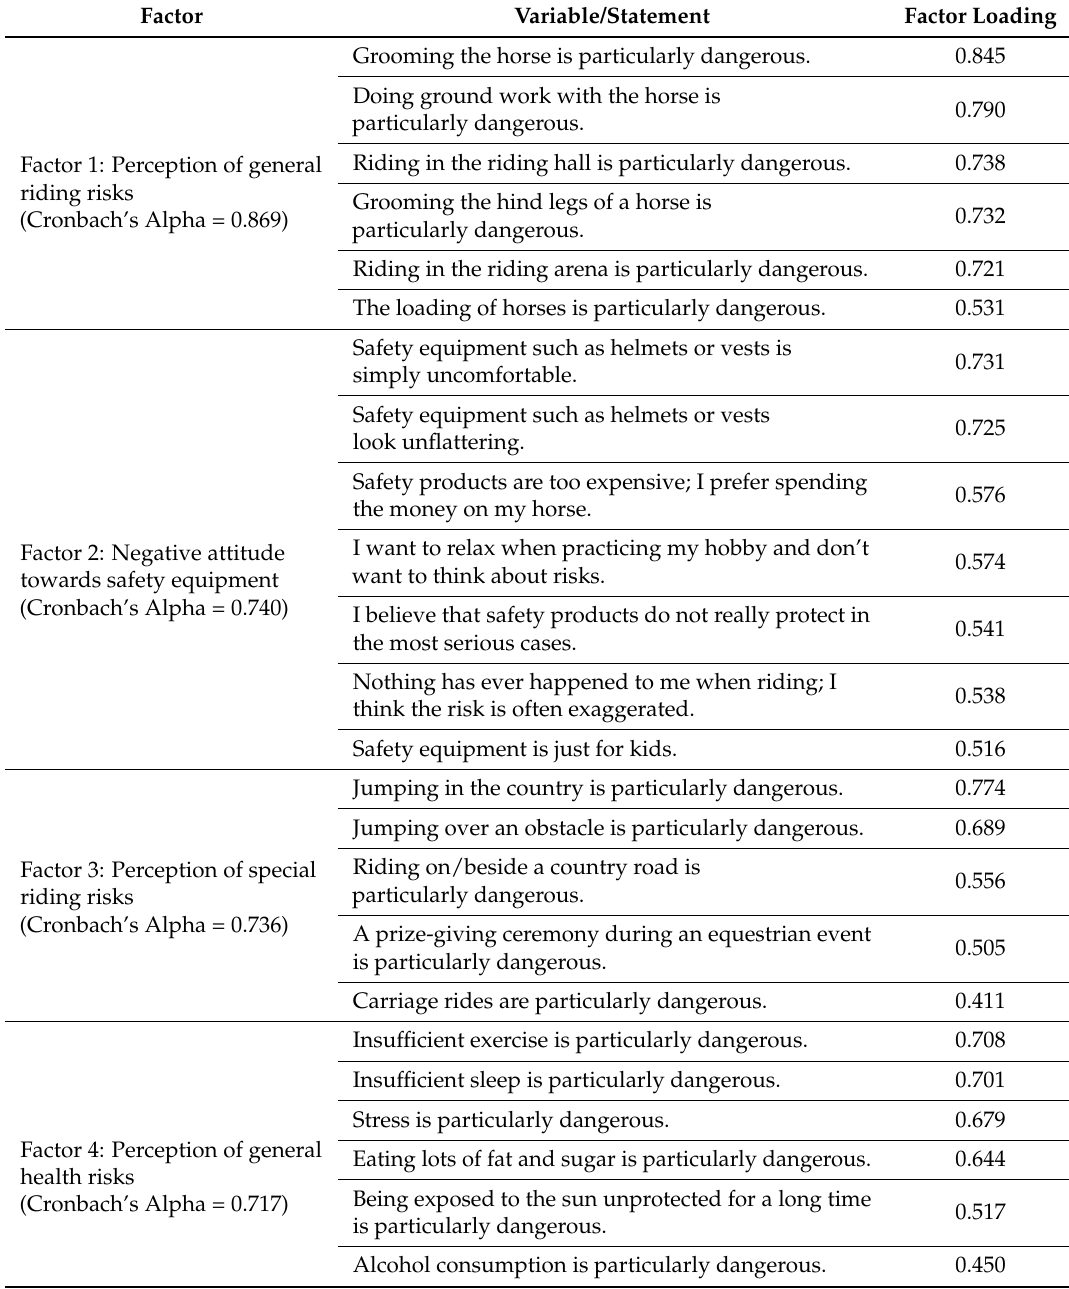
Table 5. Results of the exploratory factor